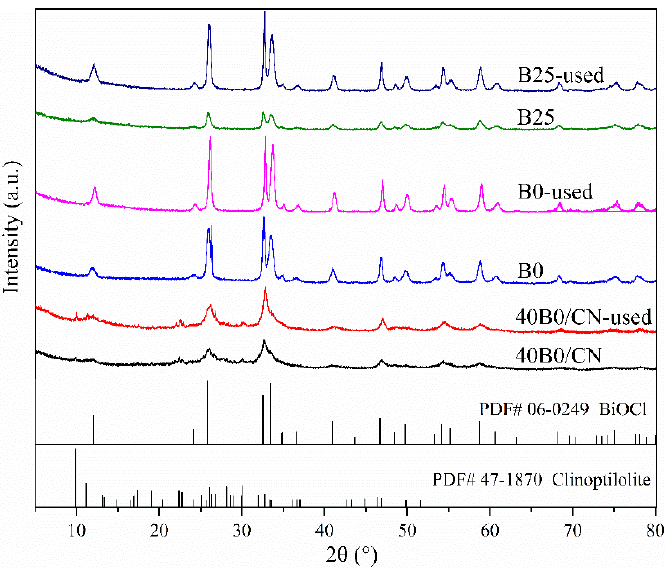
Figure 7. XRD spectra of B0, B25, and B0/CN before and after photocatalytic reaction under sunlight.